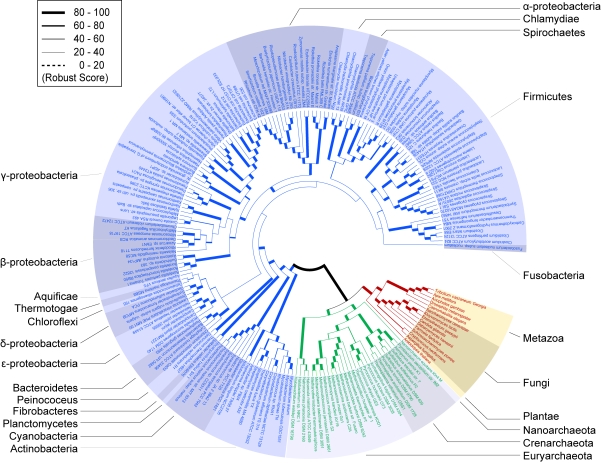
Tree of life based on genome context networks of 195 representative species.Robustness proportions are roughly represented by line width (see the legend at the upper left); exact numbers are given in Figure S4. Detailed discussion can be available in Table S4. Labels and color shadings denote various frequently used divisions. Red section, Eukaryota; green, Archaea; blue, Bacteria.